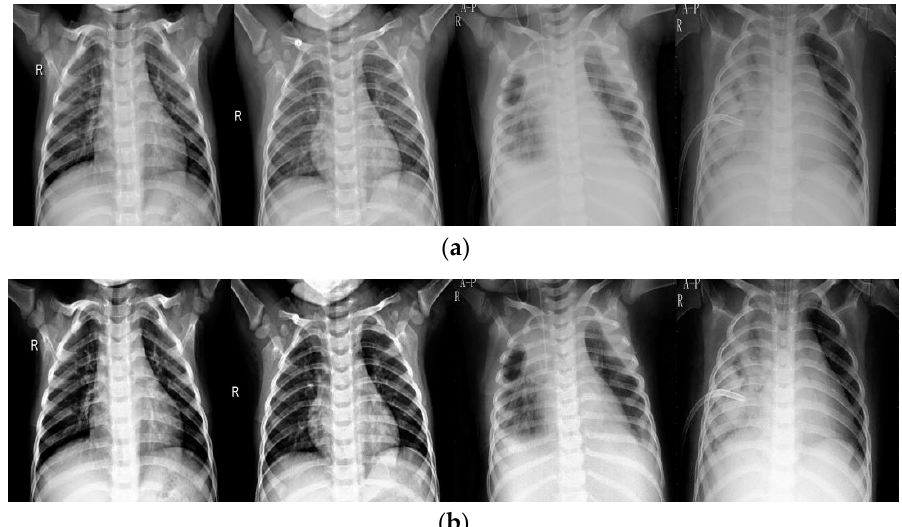
Figure 2. Comparison of original and enhanced images. ( a ) Examples of original images; ( b ) examples of enhanced images.